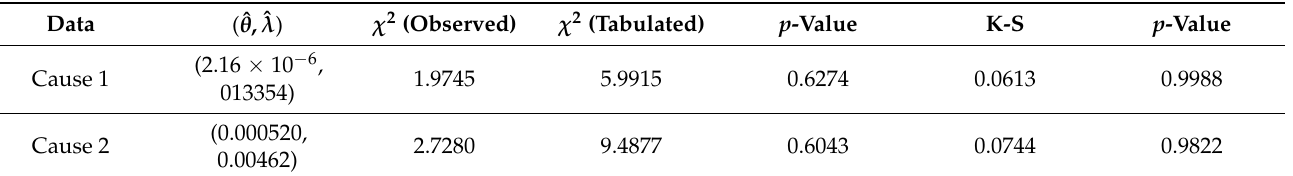
Table 1. The test statistics for Chi-square ( χ 2 ) and Kolmogorov-Smirnov (K-S) for Hoel (1972) data.